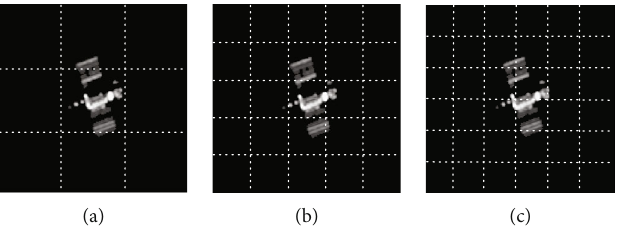
Figure 10: ISAR image rectangular region division method: (a) 3 × 3 rectangular region division method; (b) 5 × 5 rectangular region division method; (c) 6 × 6 rectangular region division